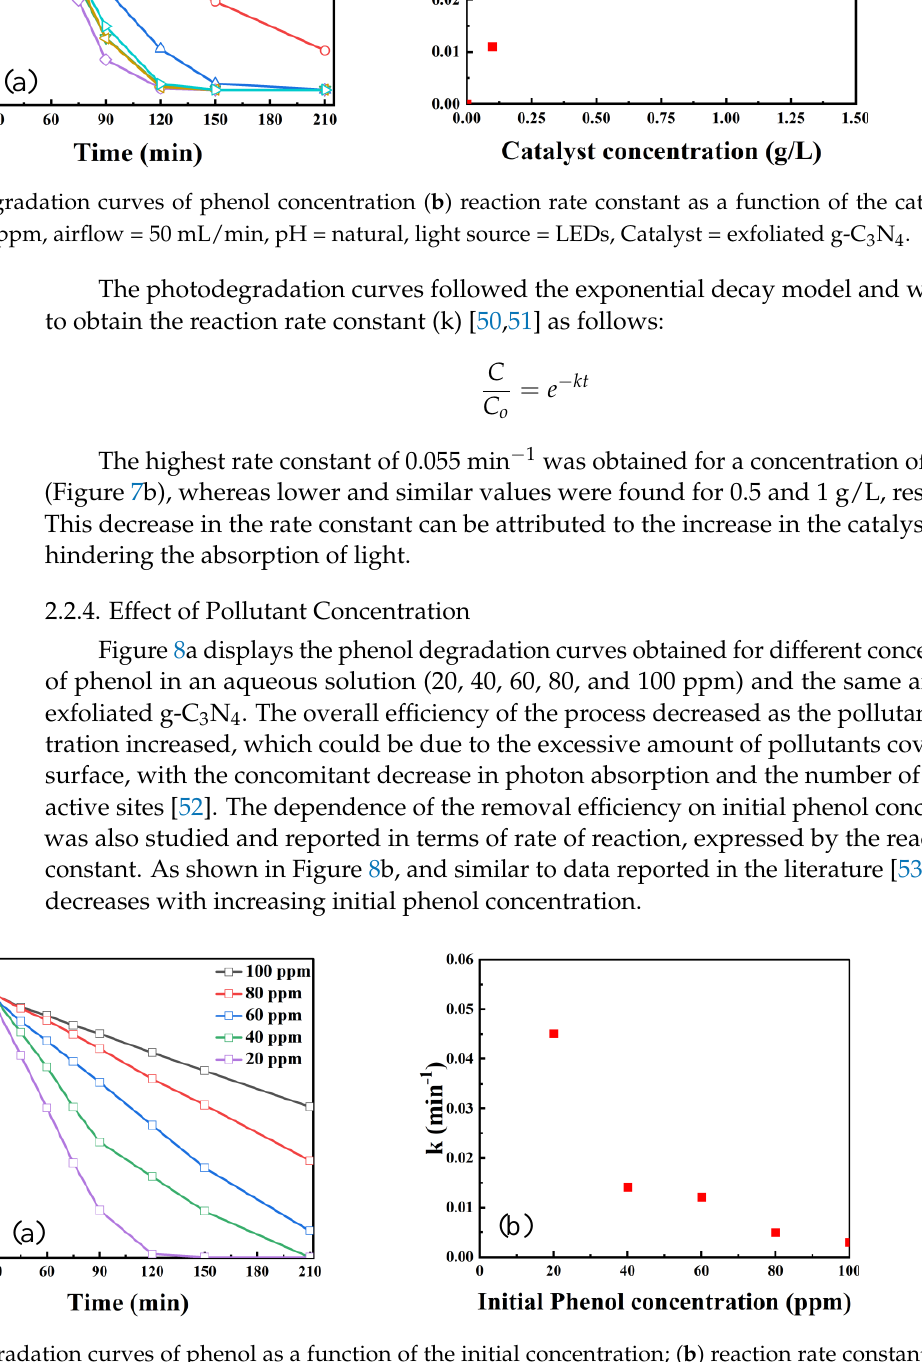
Figure 8. ( a ) Photodegradation curves of phenol as a function of the initial concentration; ( b ) reaction rate constant as a function of the initial phenol concentration airflow = 50 mL/min, catalyst = 0.5 g/L, pH = natural, light source = LEDs, Catalyst = exfoliated g-C 3 N 4 .